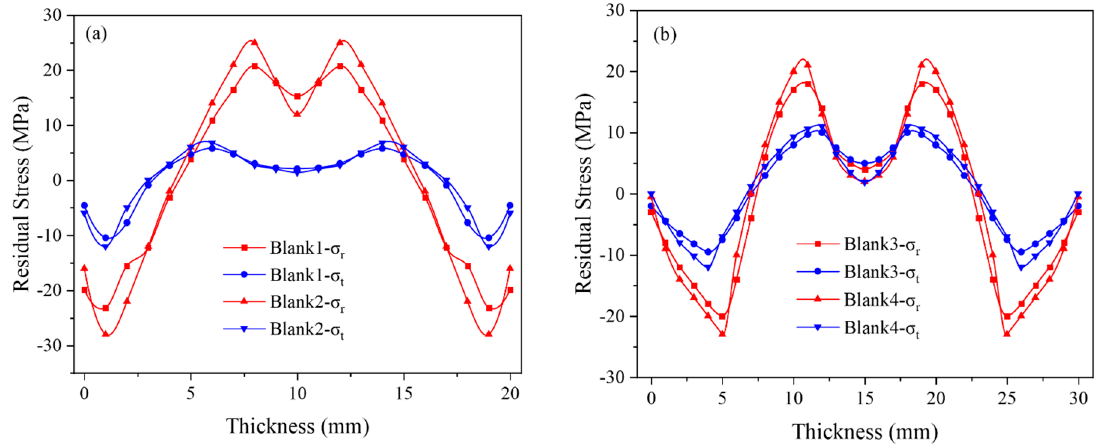
Figure 5. The initial residual stress distribution. ( a ) 20 mm. ( b ) 30 mm.